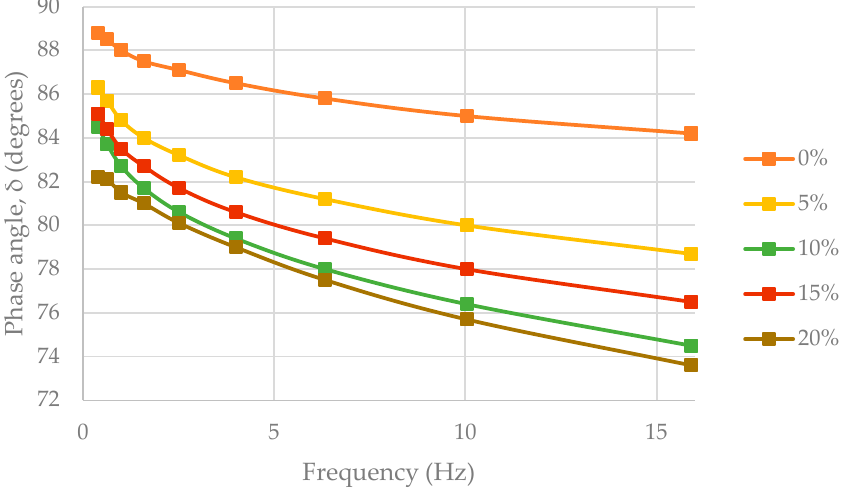
Figure 2. Representative plot of phase angle ( δ ) versus frequency at 60 °C at varying concentrations of TLA/TBP blend with toner D additive.